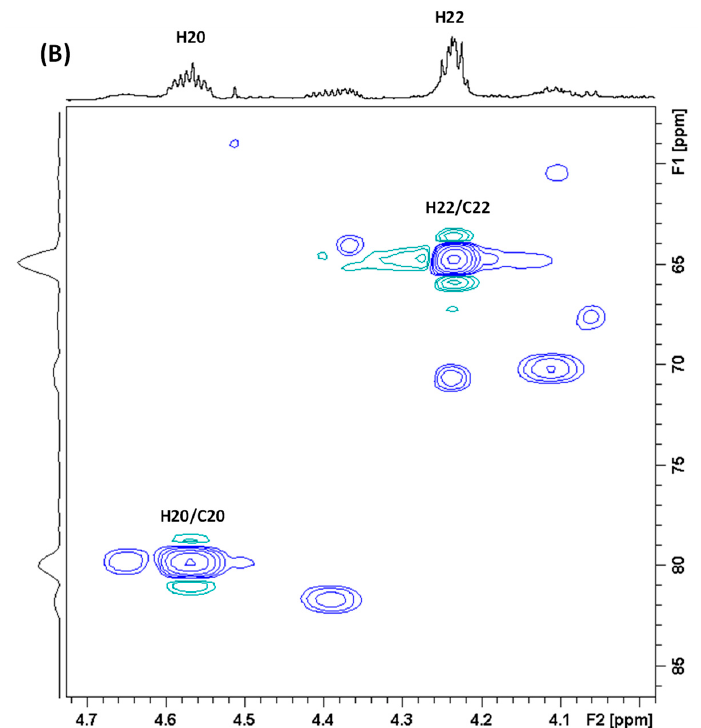
Figure 4. 2D 1 H- 13 C HSQC-NMR spectrum of the dietary supplement 15 recorded in CD 3 CN:D 2 O (80:20). ( A ) 1 H enlarged region 5.2–6.1 ppm. ( B ) 1 H enlarged region 3.98–4.72 ppm. The proton numbering of monacolins is given in Table 2.